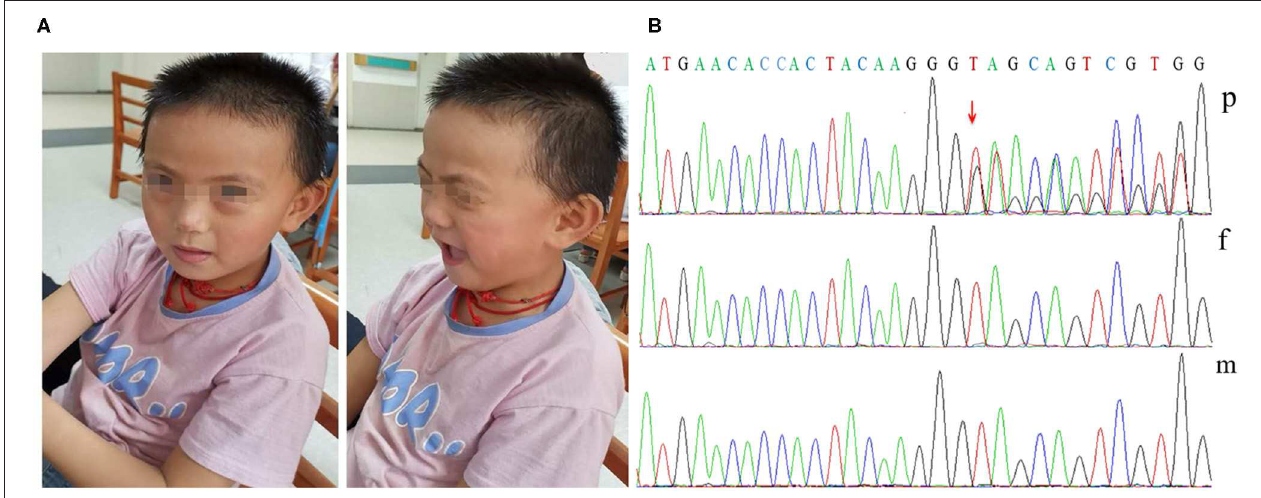
FIGURE 1 | Dysmorphic features and variant analysis. (A) Photographs of our patient at 7 years and 5 months showing brachycephaly, a flat face, a thin upper lip, and low-set ears. (B) The proband had the c.1745dupG variant of DDX3X (p), leading to a premature stop codon; however, her parents had no detectable variants (f and m).